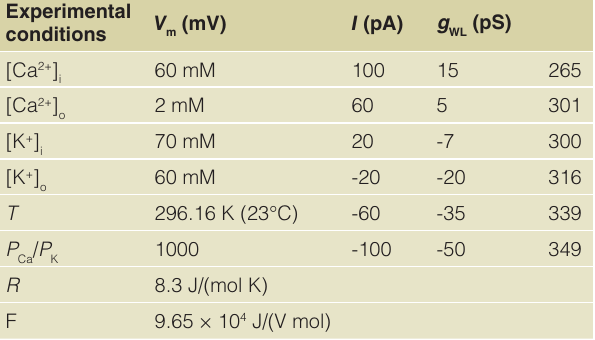
Table S1. Data for whole-lysosome conductance